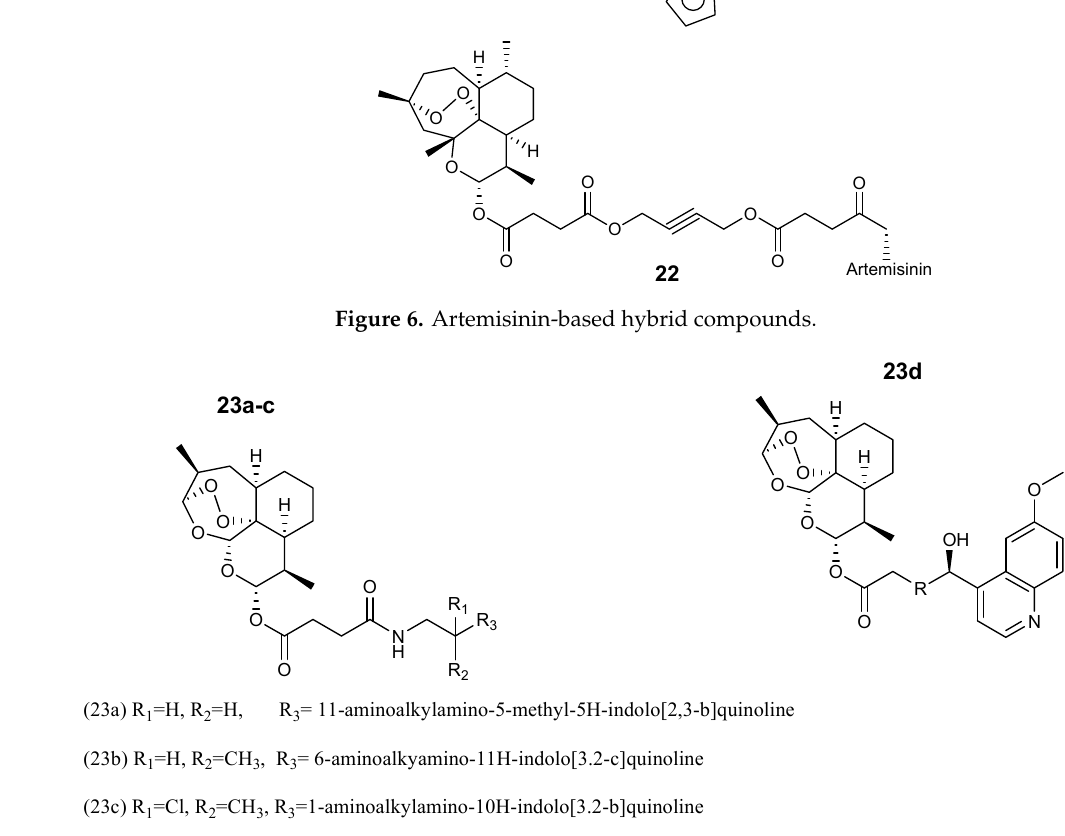
Figure 7. Structure of the artesunate–quinoline-based hybrid compound ( 23 ).